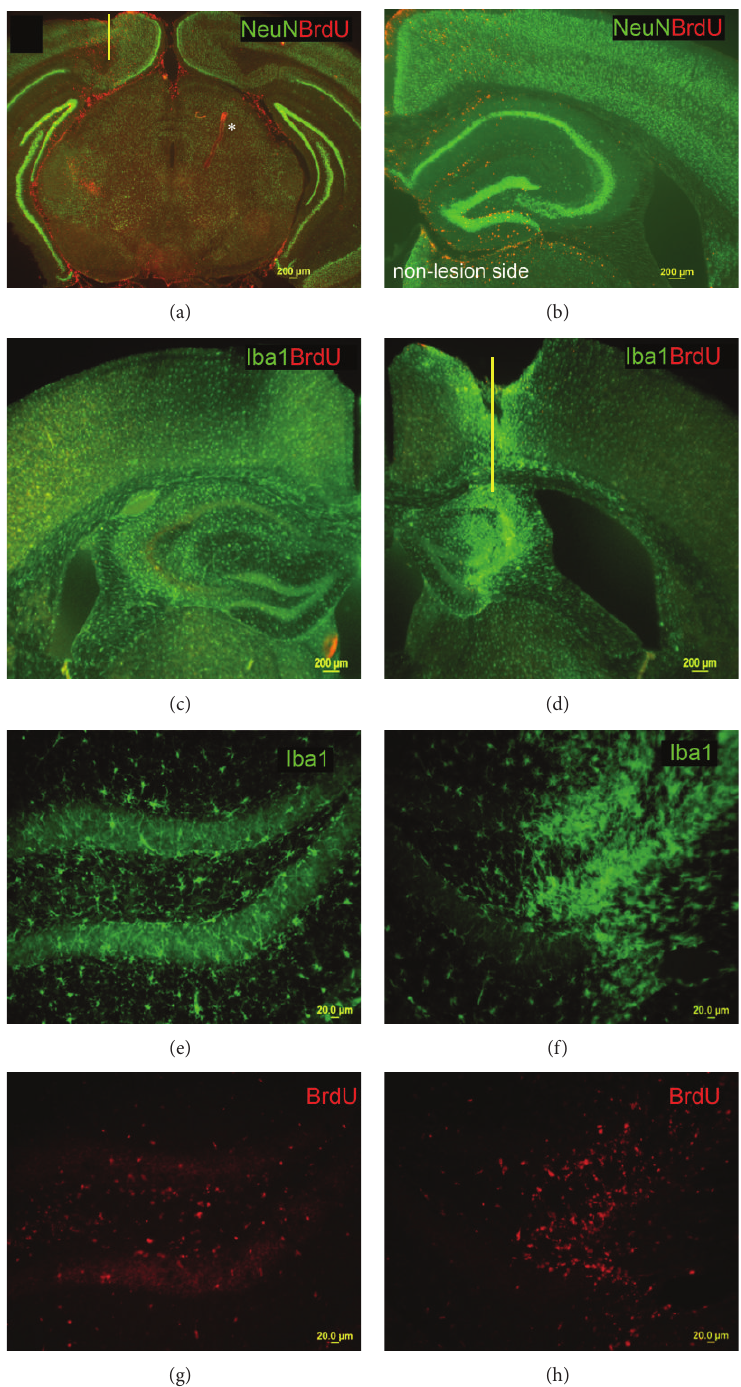
Figure1:Cellularresponsetoinsertionandremovalofamicroneedle.(a)LowpowerviewofcellslabeledwithBrdUinregionofhippocampus and midbrain (BrdU = red; NeuN = green); needle was inserted on the right side of brain (yellow line). BrdU injections were given on the day of lesion and subsequent two days. Image taken one week after lesion. BrdU+ cells are found along the needle track and in the subarachnoid space and vasculature on both sides of brain. Scale bar = 200 𝜇 m for panels (a), (b), (c), and (d). (b) Hippocampus (rostral to section in (a)) from the same animal on the unlesioned side. BrdU+ cells are seen in cortex, corpus callosum, the subarachnoid space, dentate gyrus, subgranular zone, and stratum lacunosum molecular of the hippocampus (one week after lesion). (c) Nonlesioned hippocampus opposite the lesioned hippocampus in panel (d) (2wks after lesion). (d) Site and track of needle insertion (yellow line). Two weeks after lesion. (e) Nonlesioned hippocampus at higher power (Iba 1 = green scale; bar = 20 𝜇 m for panels (e), (f), (g), and (h)). (f) Iba1+ cells in lesioned hippocampus. (g) BrdU+ cells on nonlesioned side, corresponding to panel (e). (h) BrdU+ cells on lesioned side, corresponding to panel